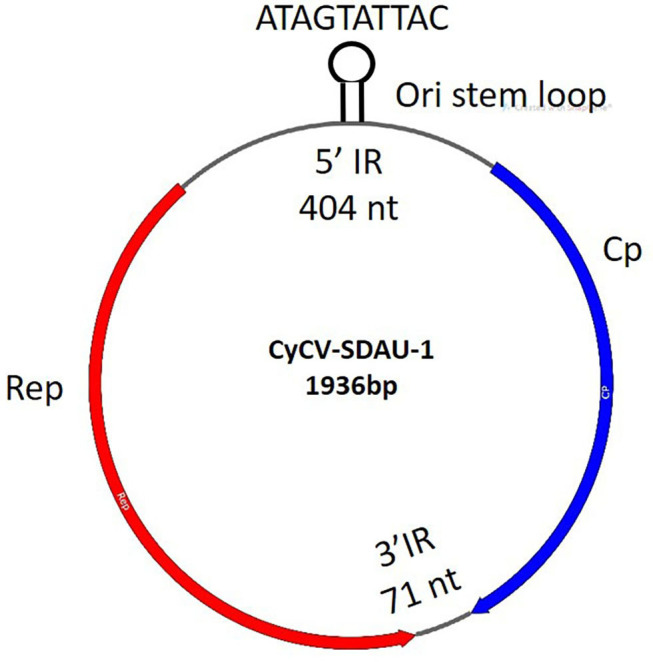
Gene structure comparison between CyCV-SDAU-1 and three other chicken cycloviruses. Compared with CyCV-SDAU-1, the other three cycloviruses showed circovirus characteristics.